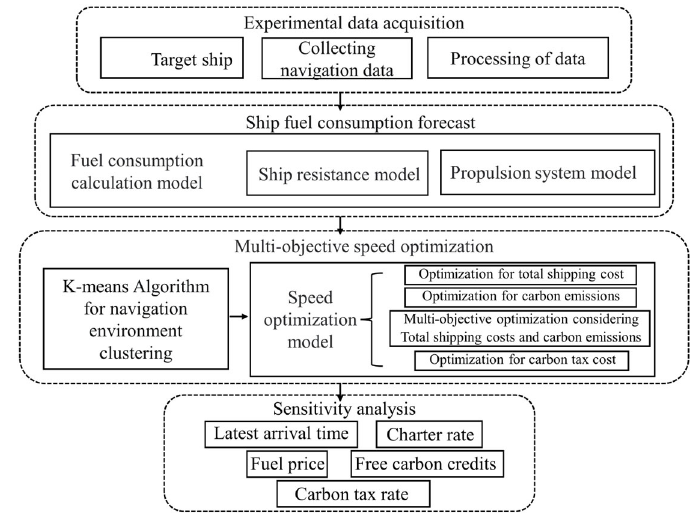
Figure 3. Diagram of the entire research process.